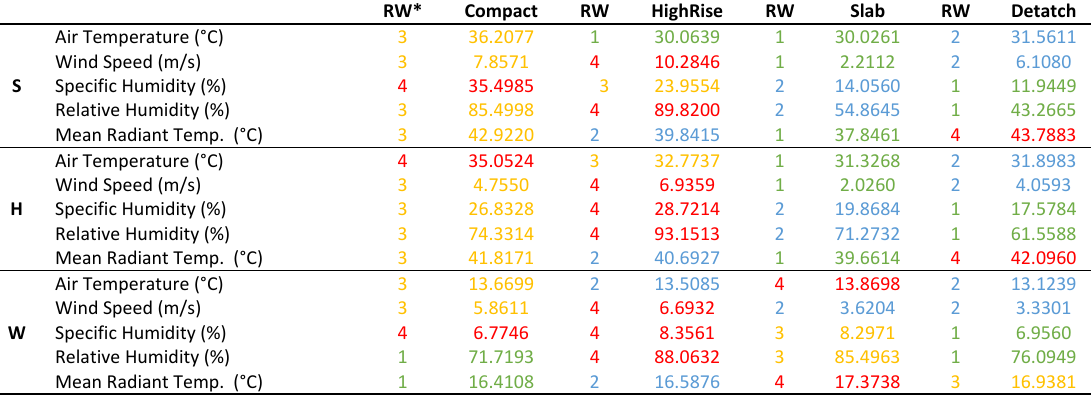
*RW (Rank Weight): The weight assigned to each parameter based on its acquired rank Green represents the first, blue the second, orange the third and red the fourth rank Table 7: Final ranking status of selected morphotypes Table 7: Final ranking status of selected